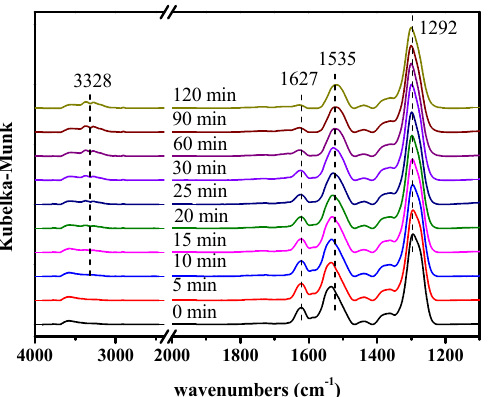
Figure 15. In situ DRIFTs spectra of the MnAlO x catalyst under an atmosphere of 500 ppm NH 3 at different times after adsorption of 500 ppm NO + 6.5 vol. %O 2 /N 2 of at 210 °C and flowing of N 2 for 30 min.